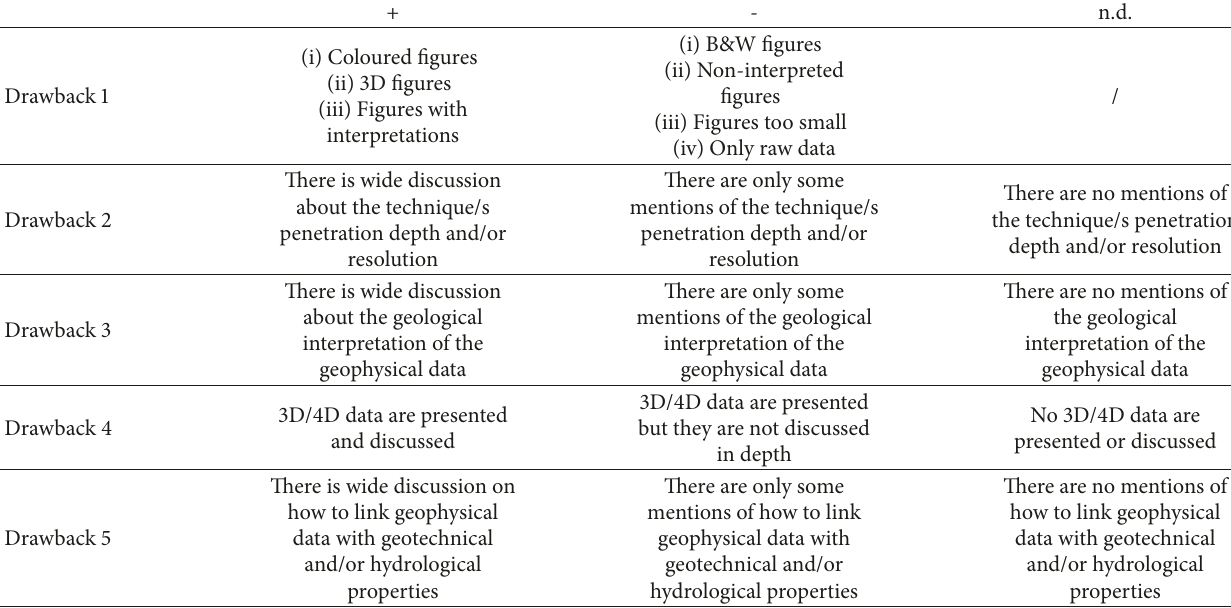
Table 4: For each drawback, this table explains how the three-level scale (+, -, and n.d., which mean that many/some, insufficient, and non-discussed efforts were made to overcome the limitations) was applied.